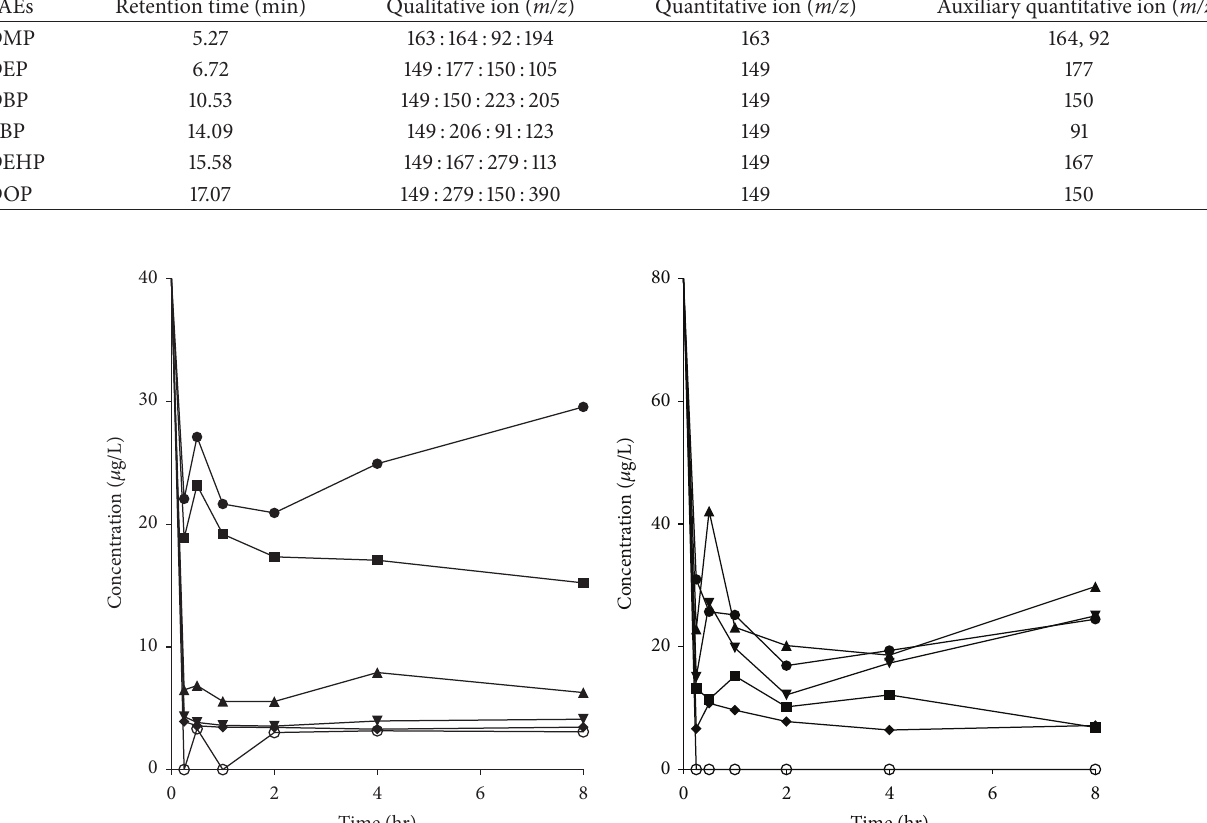
Table 1: Quantitation information of PAEs for GC-MS.